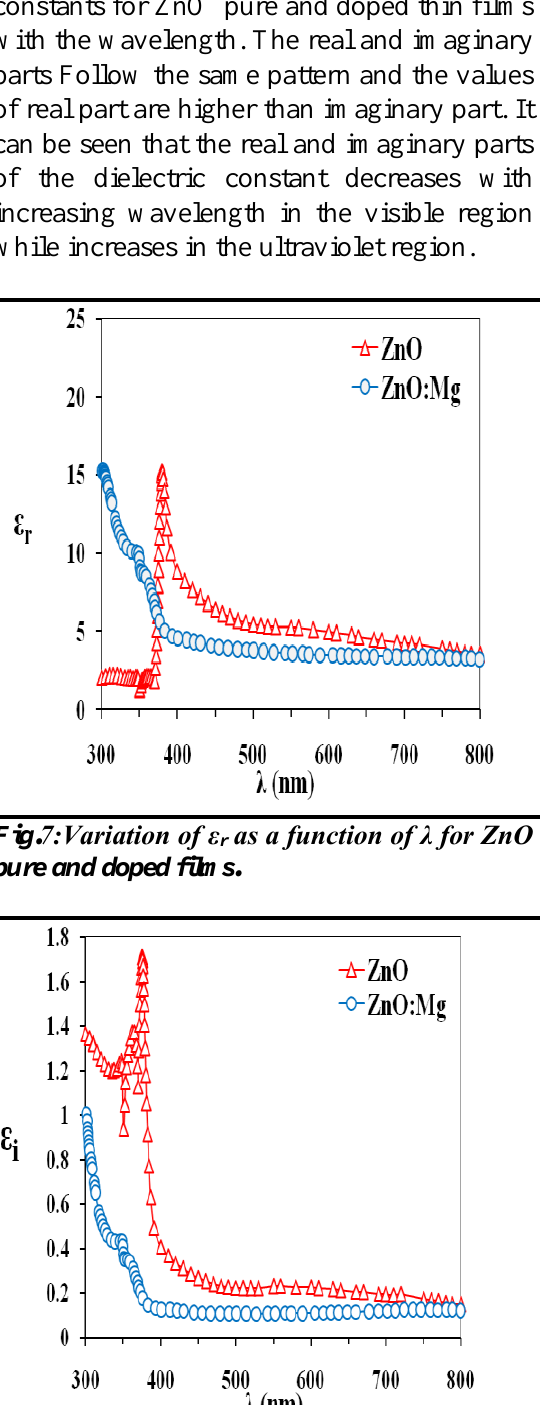
Fig.8:Variation of ε as a function of λ for ZnO i pure and doped